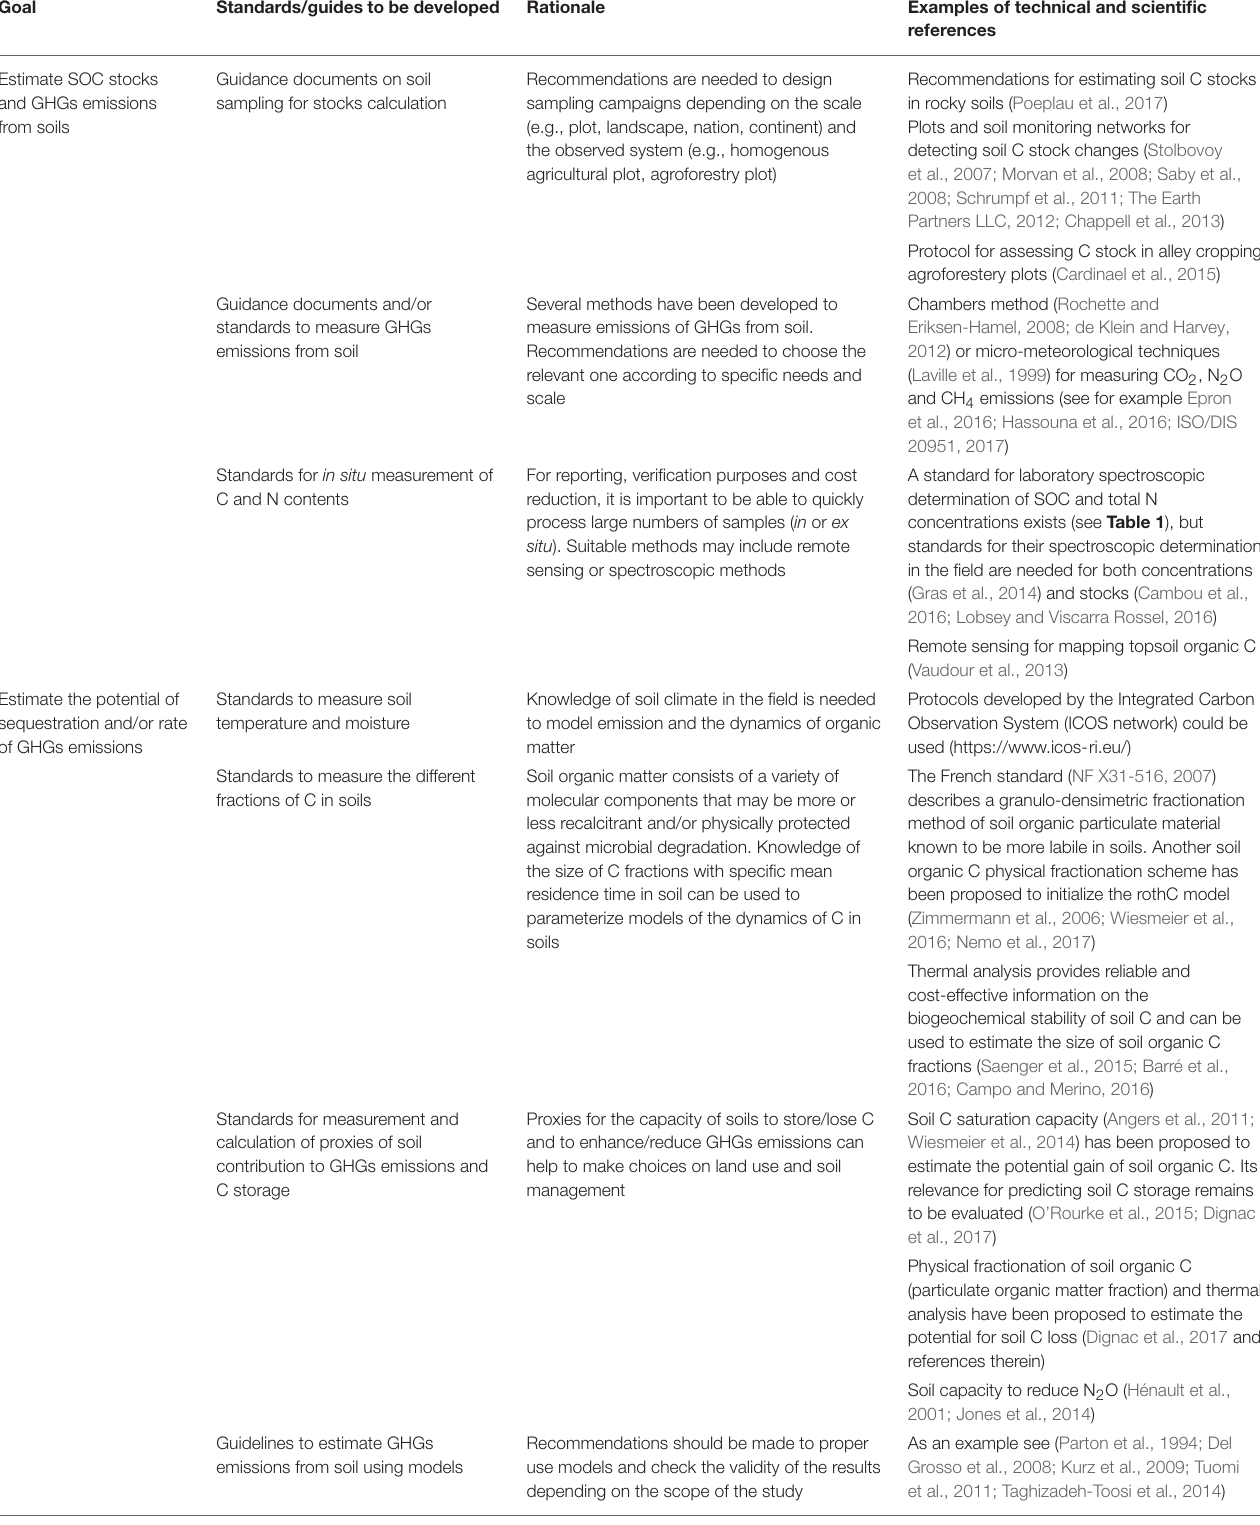
TABLE 2 | Suggested new standards and guidelines to facilitate policy